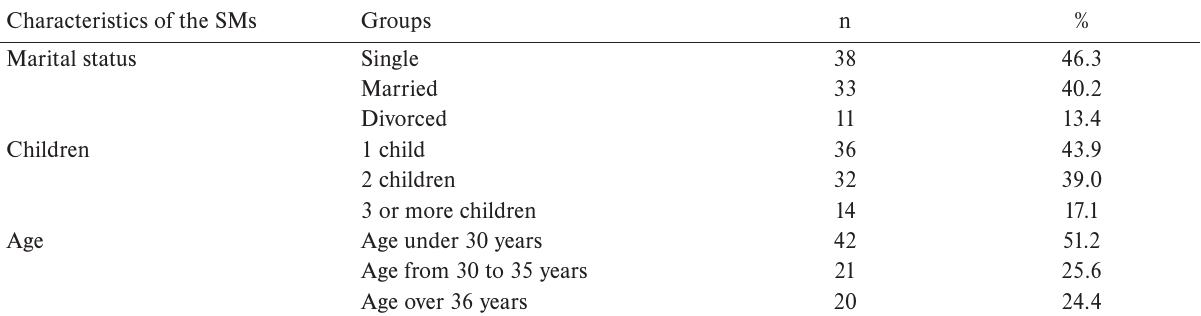
Table 3. The background characteristics of the surrogate